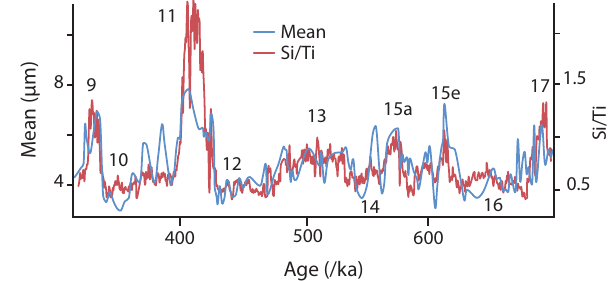
Fig. 7. Comparison of the mean values (after Folk and Ward, 1957) and the Si / Ti ratio as a proxy for bioproductivity in Lake El’gygytgyn between marine isotope stages 17 and 9. This short time period was exemplarily chosen to visualize grain-size and Si / Ti variability during several glacial–interglacial cycles includ- ing the super interglacial MIS11. The relationship is consistent over the entire record. Variations on a glacial–interglacial timescale but also of higher frequency are well reflected by the grain-size data. Grain-size distributions during MIS11 do not differ compared to other